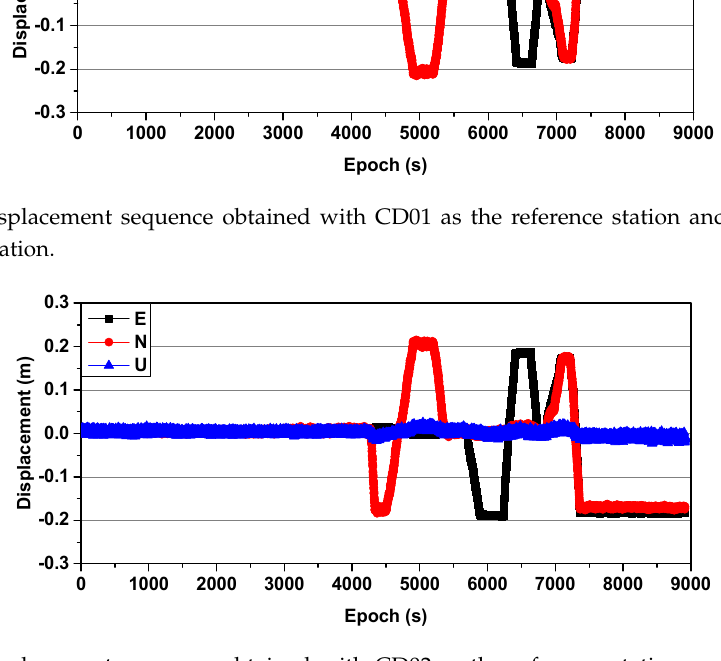
Figure 6. Displacement sequence obtained with CD02 as the reference station and CD01 as the monitoring station. E—east; N—north; U—upward.